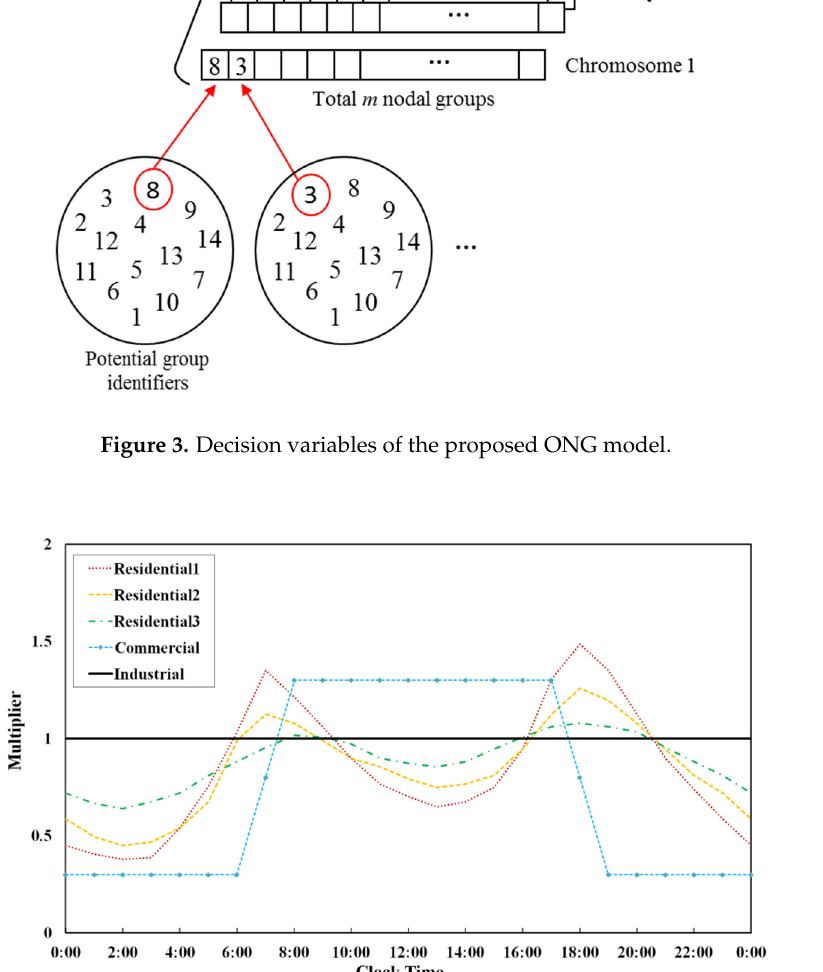
Figure 4. Diurnal demand curves for five user types: Residential 1 (apartments), Residential 2